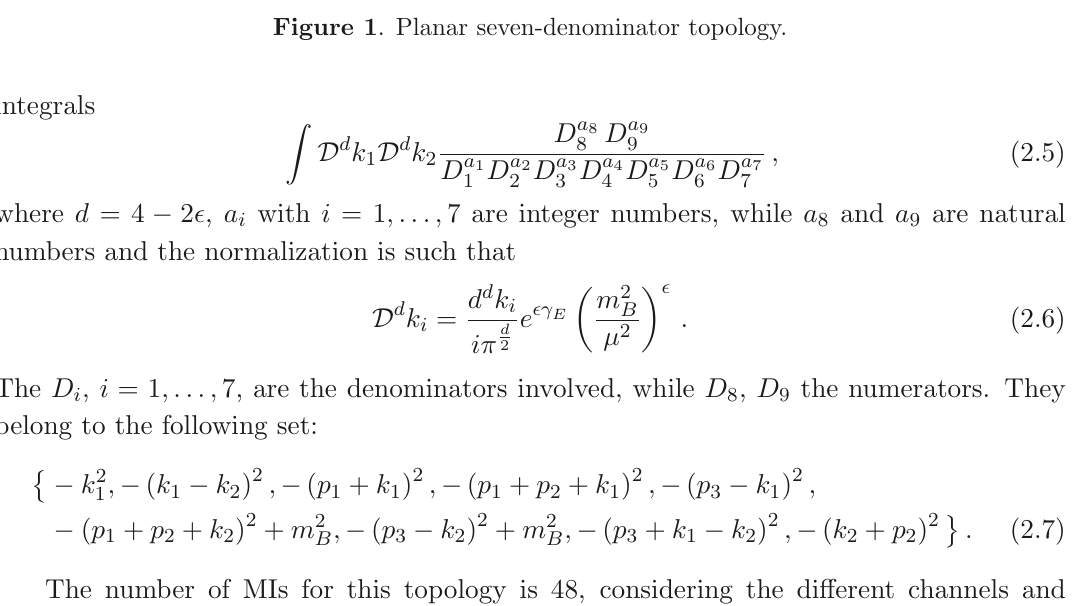
Figure 1 . Planar seven-denominator